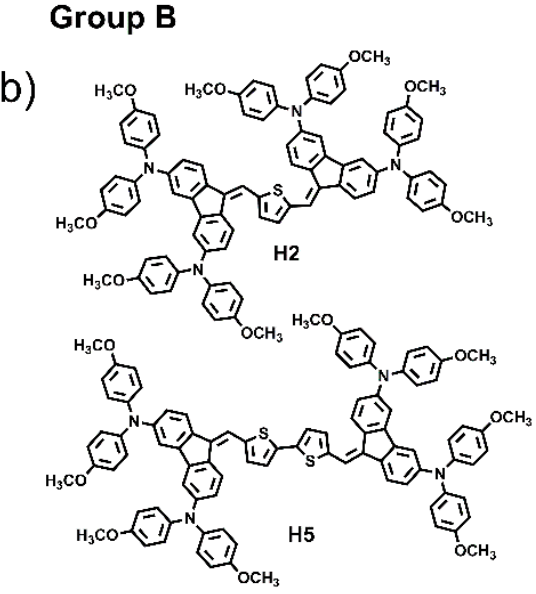
Figure 1. Chemical structures of H1–H6 .